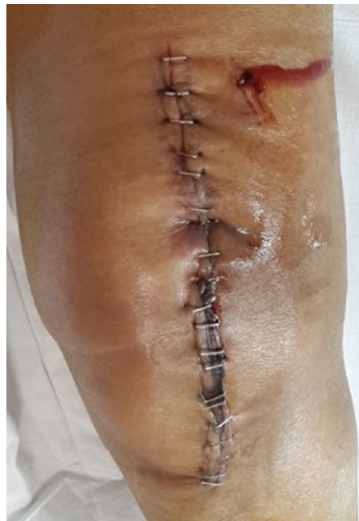
Figure 1. Discharge from the drain site.